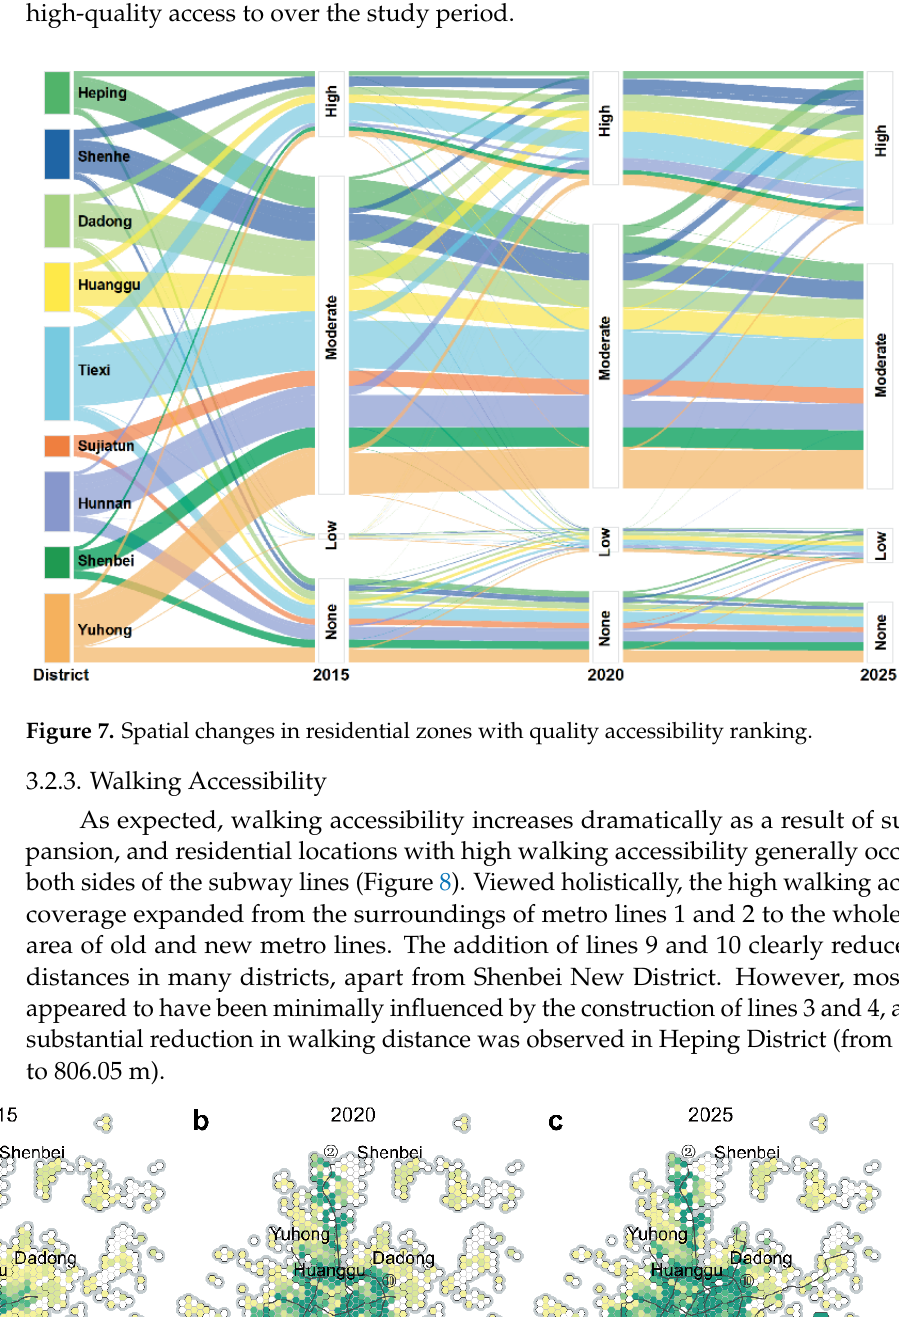
Figure 6. Spatial quality accessibility to healthcare services at different stages of subway system development: ( a ) accessibility in 2015; ( b ) accessibility in 2020; ( c ) accessibility in 2025.